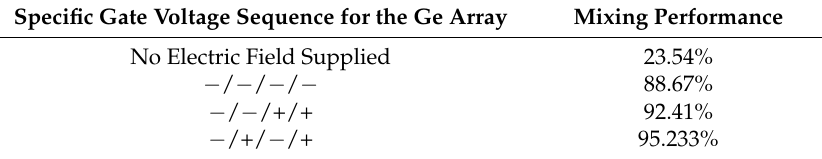
Table 1. Device efficiency for the integrated 3D high-throughput micromixer (Figure 8) with the central GE array subjected to different gate voltage